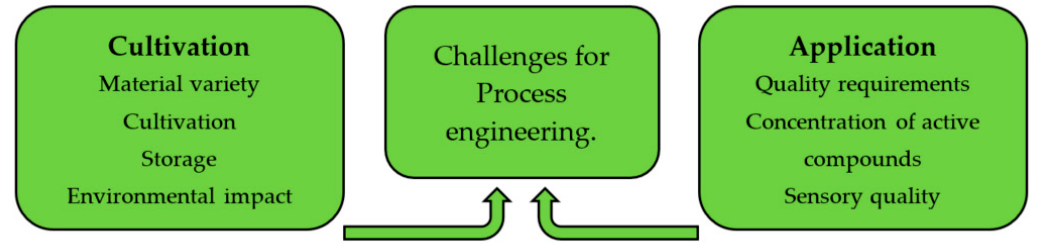
Figure 1. Challenges for process engineering between agriculture and application.